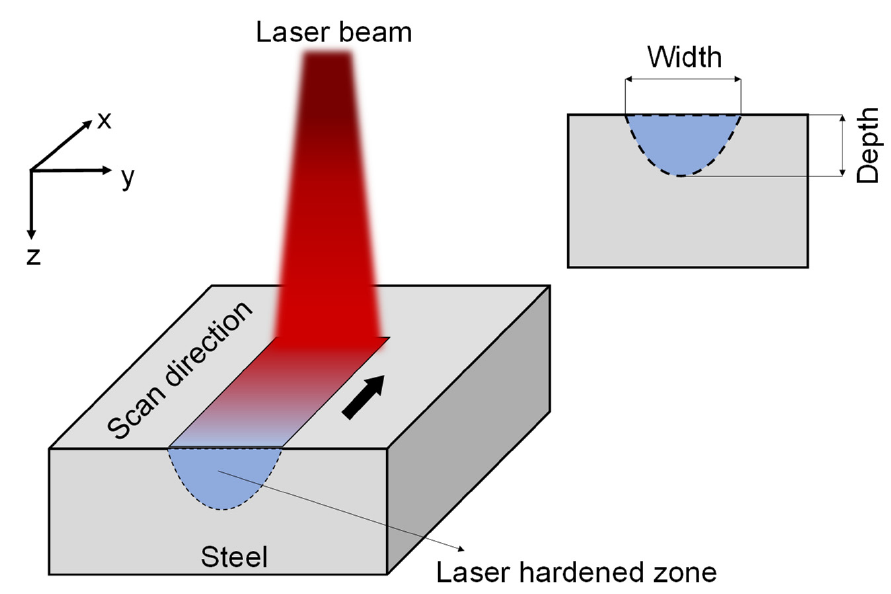
Figure 2. A single laser-hardened track showing associated depth and width.